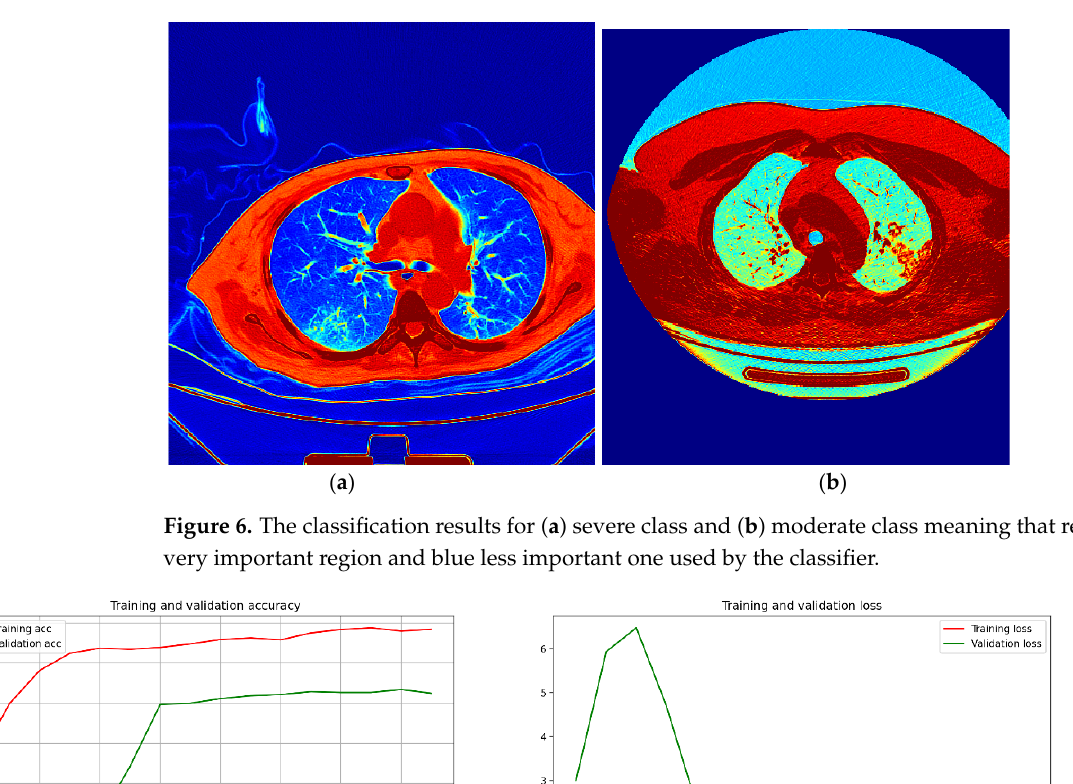
Figure 6. The classification results for ( a ) severe class and ( b ) moderate class meaning that red it’s a very important region and blue less important one used by the classifier.